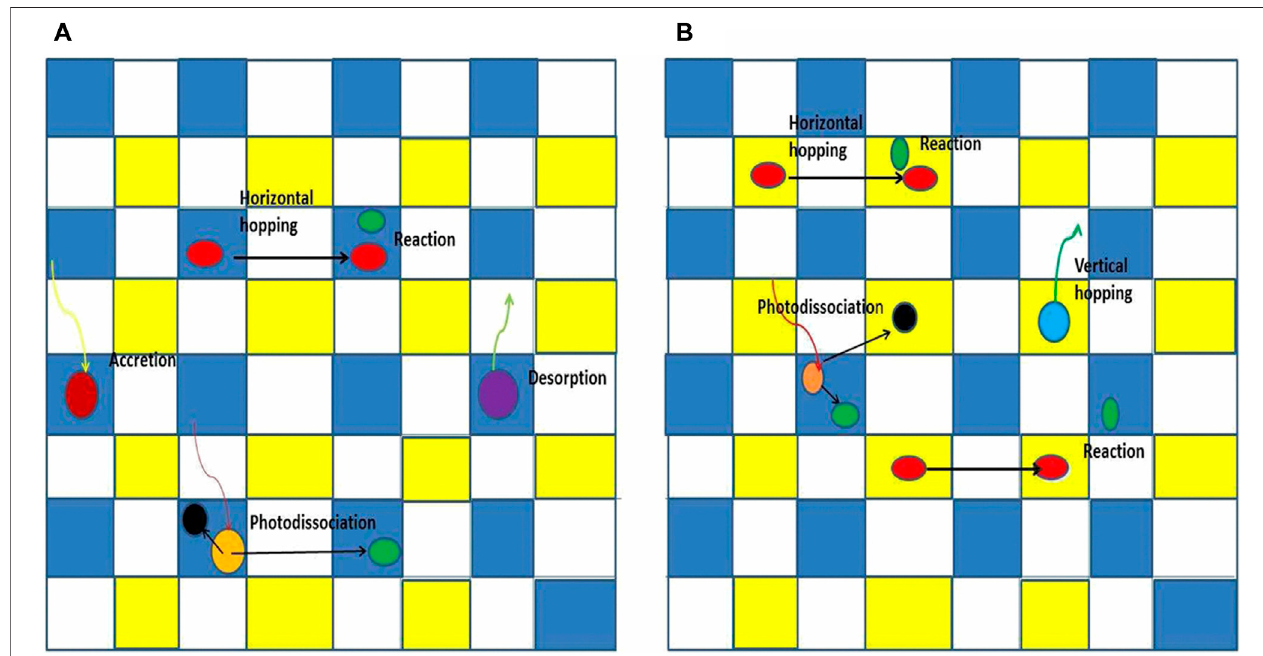
FIGURE3| Drawings ofstochasticmotionsinarectangulargrid ofsitesintwosituations. Majorstochasticprocessesongrainsurfacesintheformofarectangular grid ofsites. Blue sitesare normal sites, occupied bynormal species, whileyellowsitesare interstitialsites, normallyunoccupied oroccupiedby weaklybound interstitial species,andwhitesitescannotbeoccupied. (PanelA) showsthetopmostlayer,while (PanelB) showsaninner(bulk)layer.Figurereproducedfrom Figure1 ofChang and Herbst. (2014).